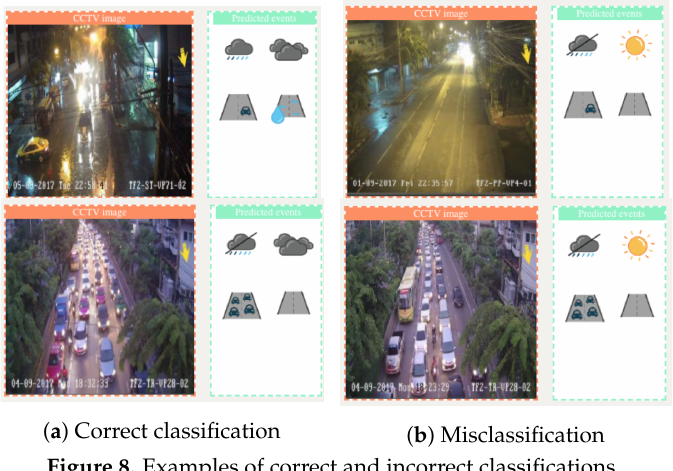
Figure 8. Examples of correct and incorrect